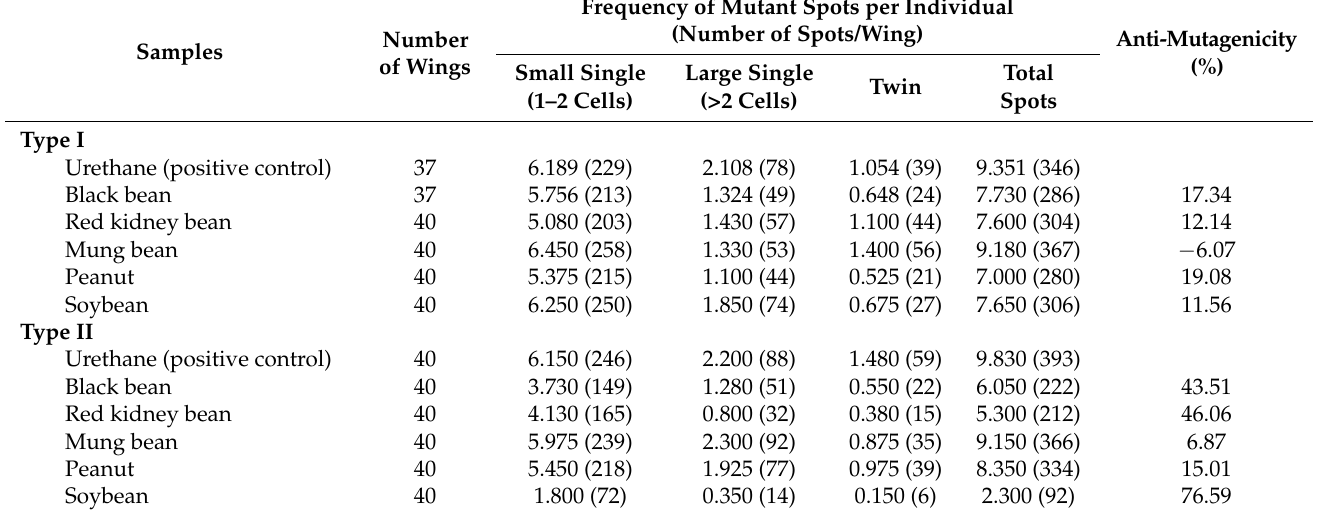
Table 4. Frequency of mutant spots observed in trans-heterozygous, high bioactivation (HB) flies following the type I and type II pre-feeding